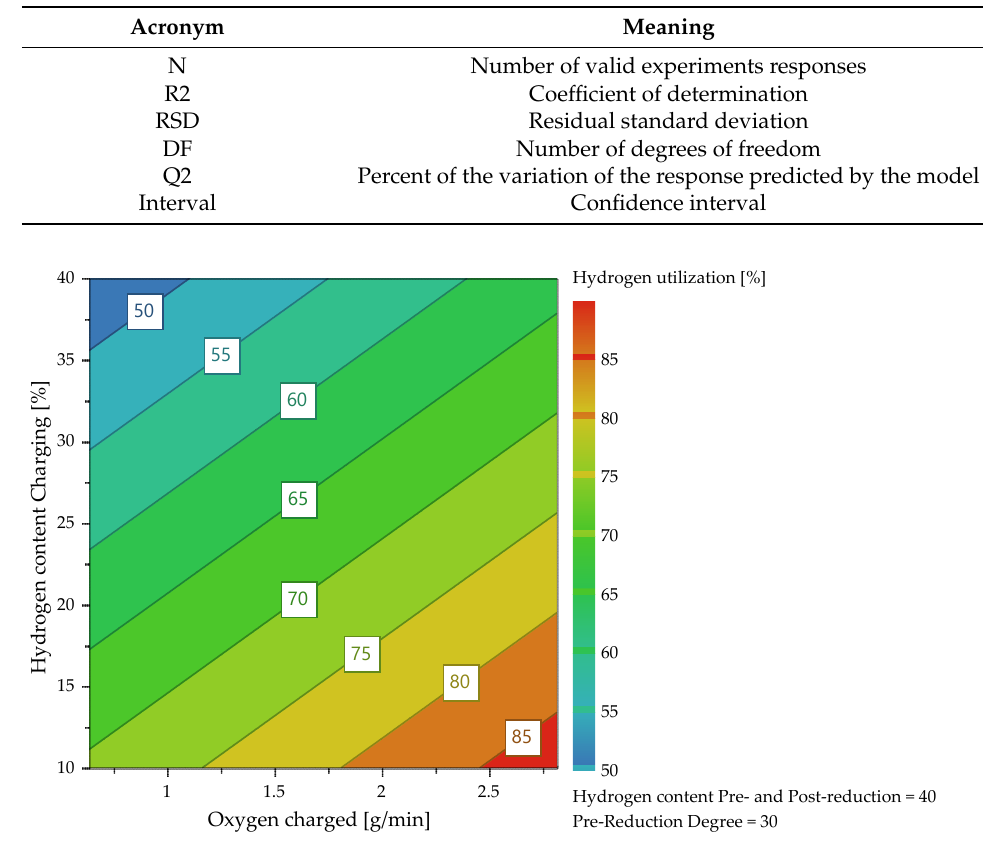
Figure 13. Average hydrogen utilization as a function of the H 2 content and the charging rate.